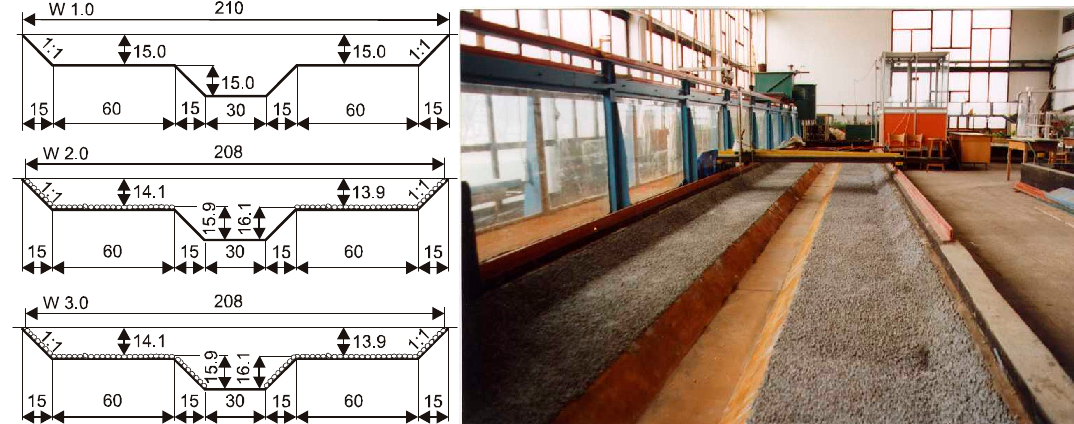
Figure 3. Cross-section schema of the channel in the analyzed variants (dimensions in cm) and a view of the channel model in the variant W 2.0.